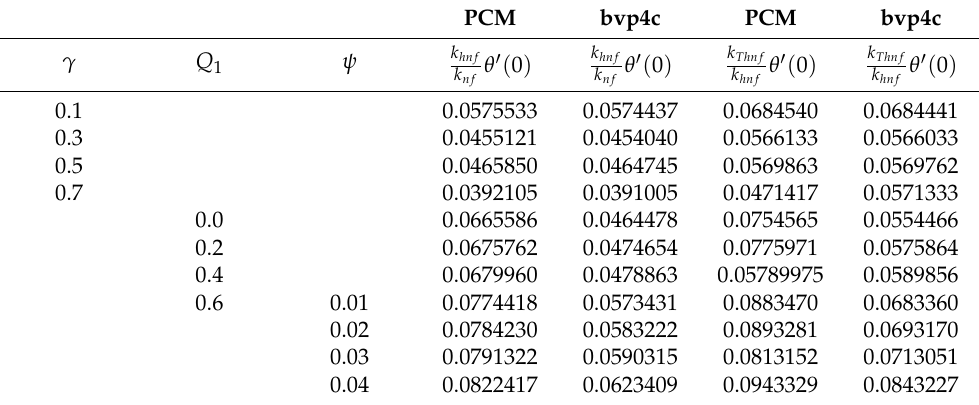
Table 2. Comparative assessment for Nusselt number between PCM and bvp4c package with hybrid and ternary hybrid nanofluid.